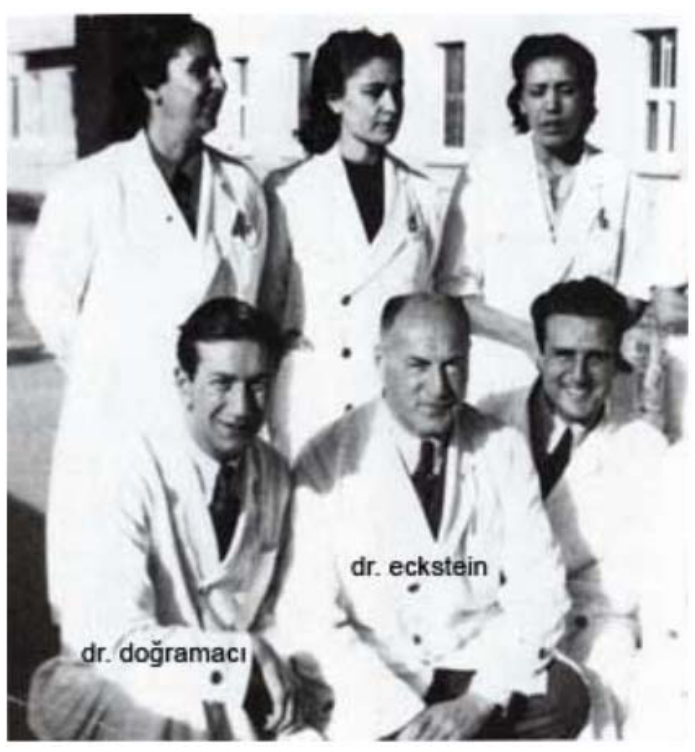
Figure 1. Dr. Eckstein and Dr.